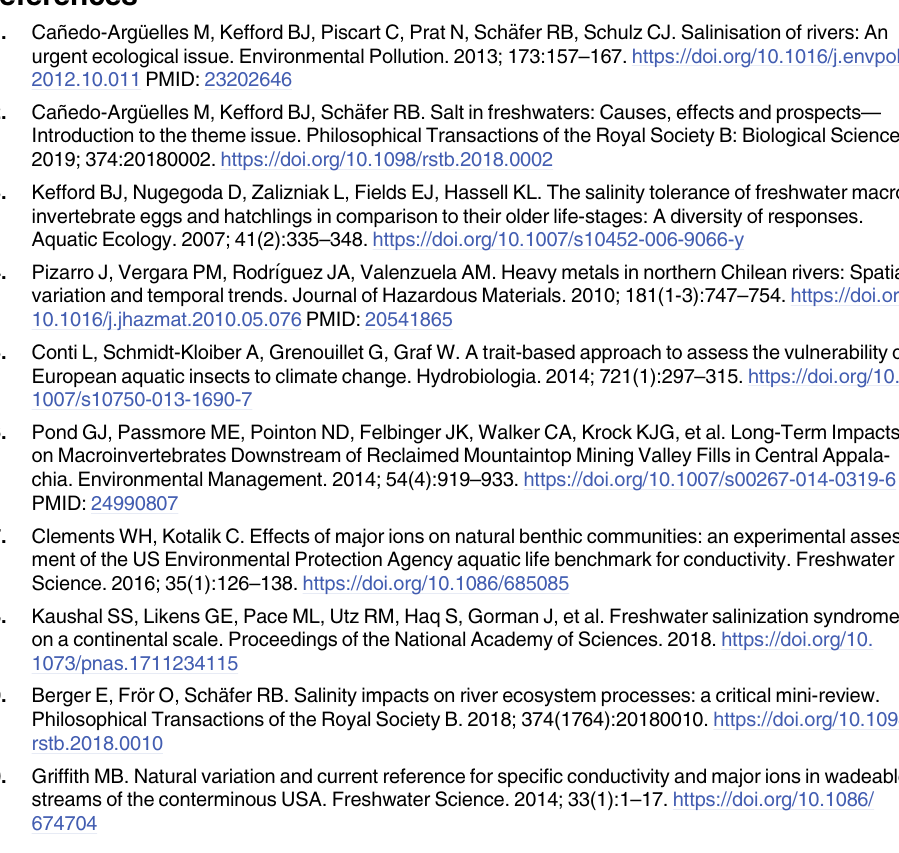
S1 Table. Repeatability and responses of each behavioral